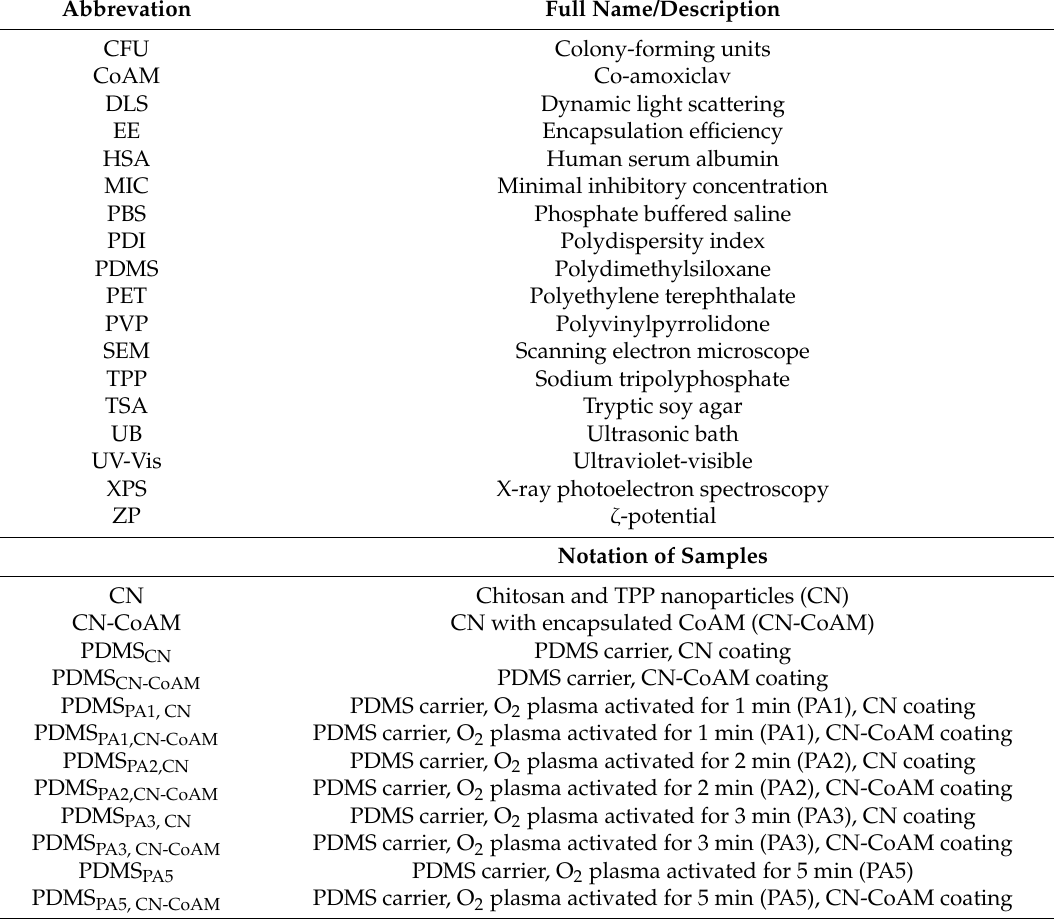
Table 1. List of abbreviations and their descriptions. Samples notation is given in the same table. Abbrevation Full